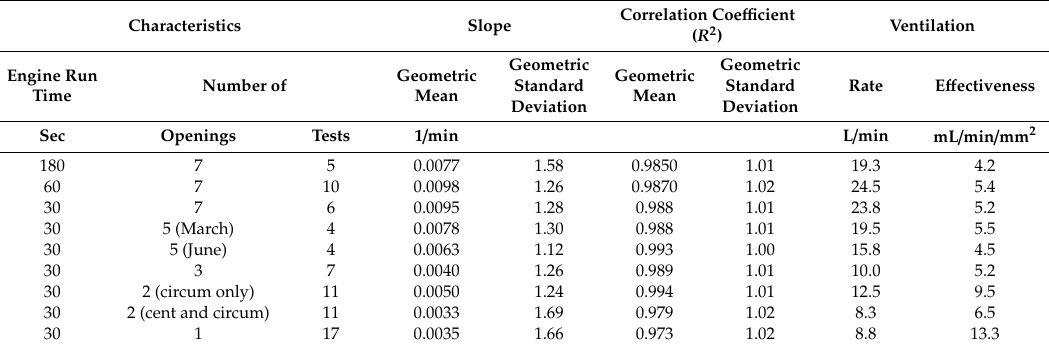
Table 1. Summary of parameters for lines fitted to data points used in plot of ln(C / C 0 ) versus time (min).